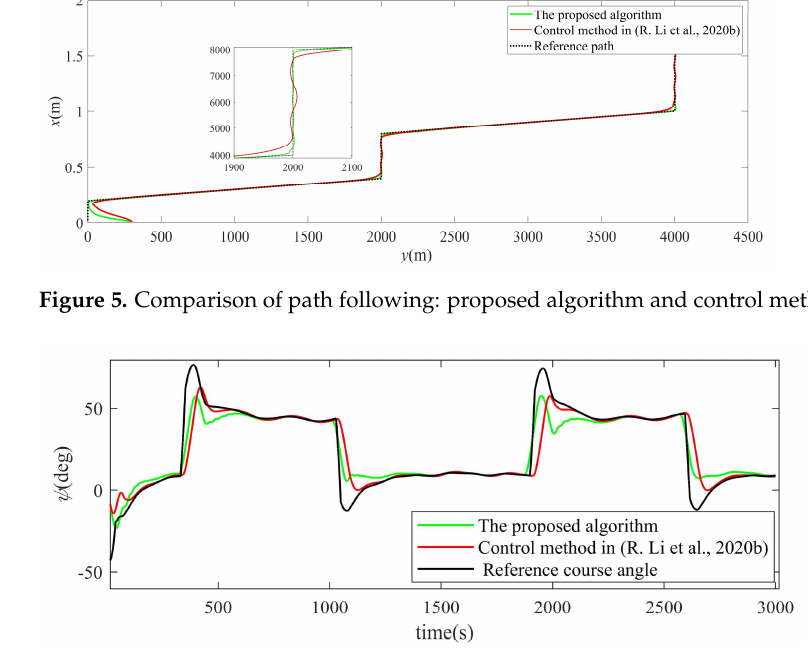
Figure 6. Comparison of course angle: proposed algorithm and control method in [32].